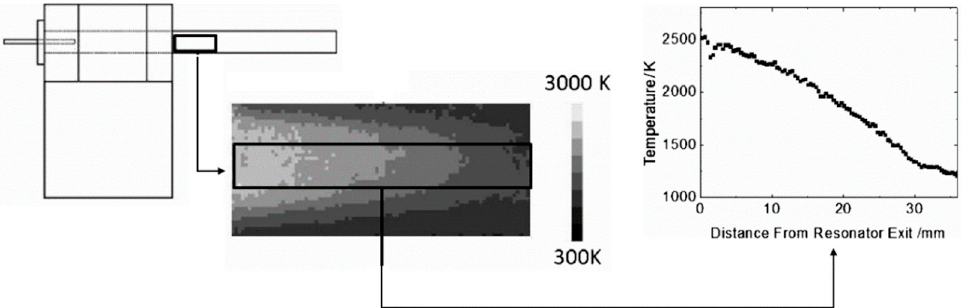
Figure 41. Temperature measurement by Hecht et al. [193] in a confined plasma flow of oxygen, nitrogen and NO as tracer. Left: measurement location; Center: two-dimensional temperature distribution; Right: temperature profile along the axis, averaged over the central 10 mm, limited by the black rectangle in the center image). Reprinted and adapted by permission from Ref. [193], Zeitschrift für Physikalische Chemie, Copyright © 2022 Oldenbourg Wissenschaftsverlag.